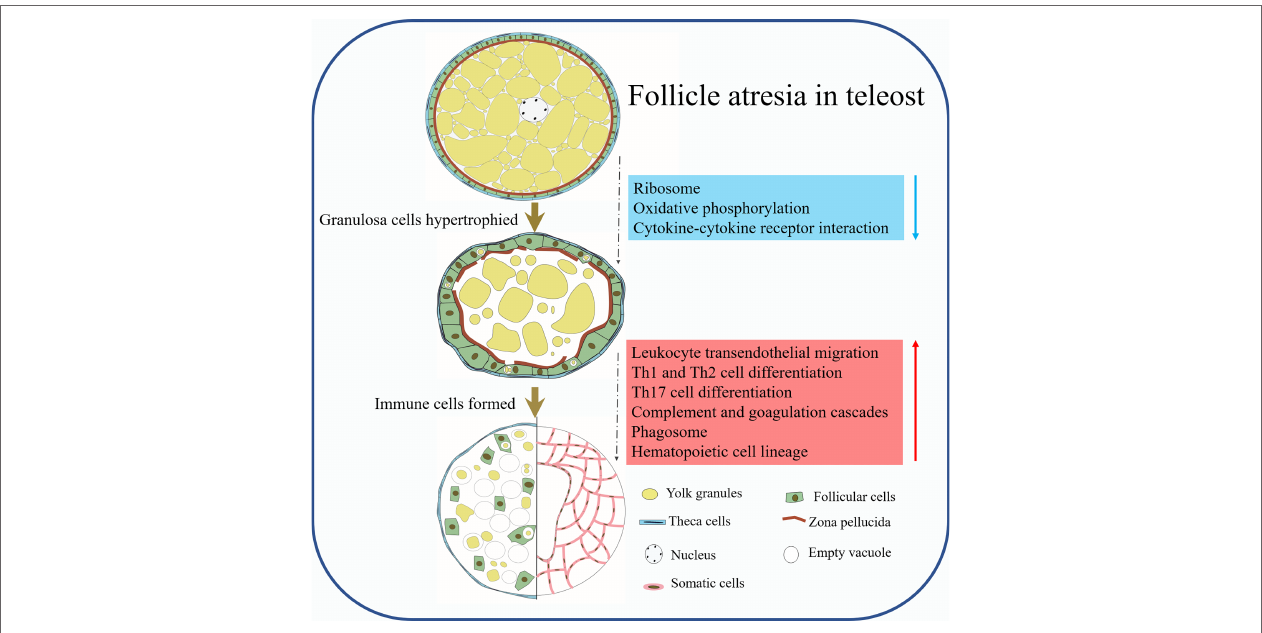
FIGURE 10 | The schematic diagram showing the working hypothesis by which somatic cells mediate the process of follicle atresia in P. argenteus